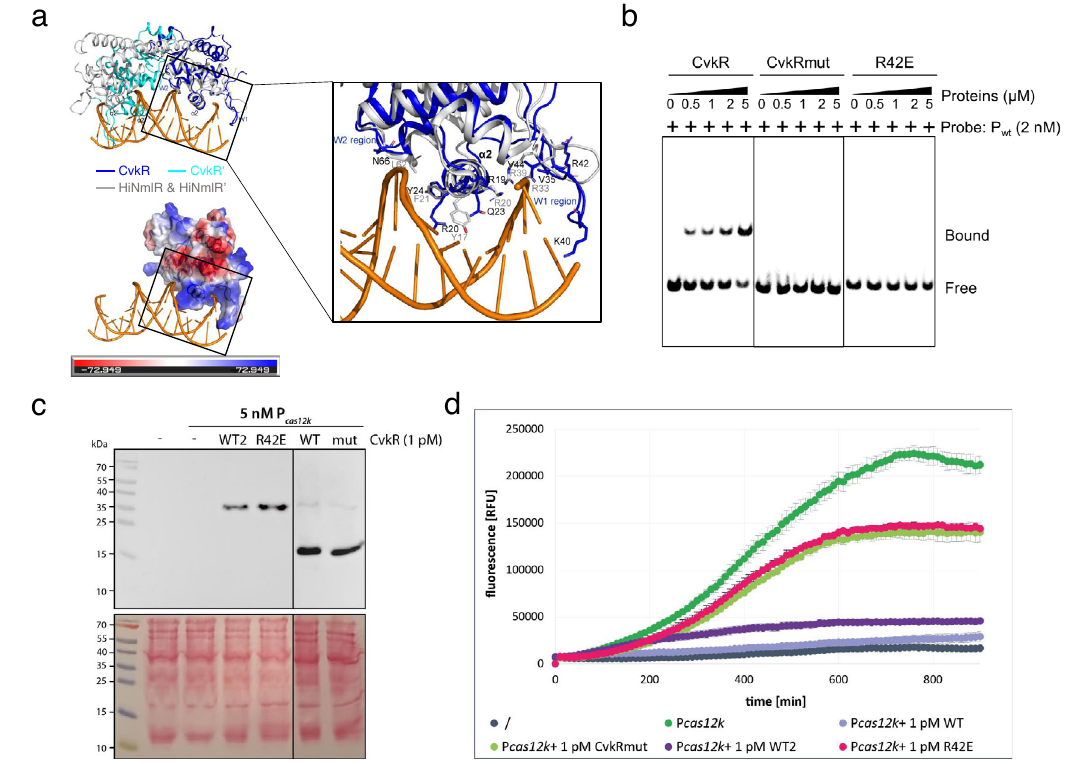
Fig. 8 | FunctionalcharacterizationofCvkR DNA-binding residues.a Upper left panel:SuperimpositionofCvkRontotheHiNmlR-promotercomplex.Twosubunits of the CvkR homodimer are colored in blue or cyan. HiNmlR homodimer and its target DNA in the HiNmlR-promoter complex (PDB code 5D8C) are displayed in gray and orange, respectively. Three regions directly participating in promoter DNA binding in the HiNmlR-promoter complex,helix α 2 and twowingedloops W1 and W2, are labeled. Lower left panel: electrostatic surface representation of CvkR highlighting the potential electropositive (blue) DNA-binding surface. Right panel: The key DNA-interacting residues reported in HiNmlR are shown in sticks and labeled in gray. The possible DNA-interacting residues in CvkR corresponding to the three DNA-interacting regions are labeled in black. b EMSAassays showing the binding of CvkR variants to P cas12k . The 33-nt P wt probe was used for the assay. The His-SUMO tags were removed from all CvkR variants used in the EMSAassays. The free probe and P wt -protein complexes are marked as “ Free ” and “ Bound ” , respec- tively. The data are representative from three independent experiments. c CvkR